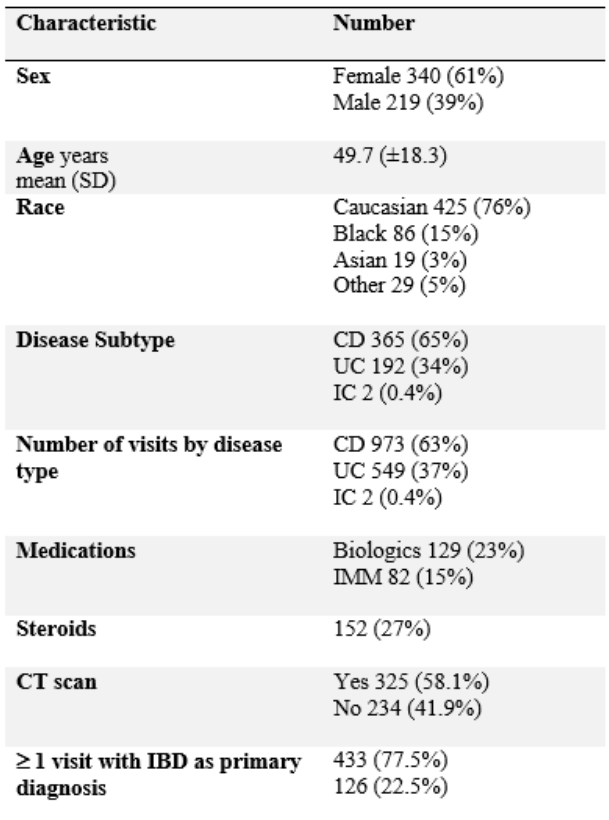
Figure 2. Baseline patient characteristics.